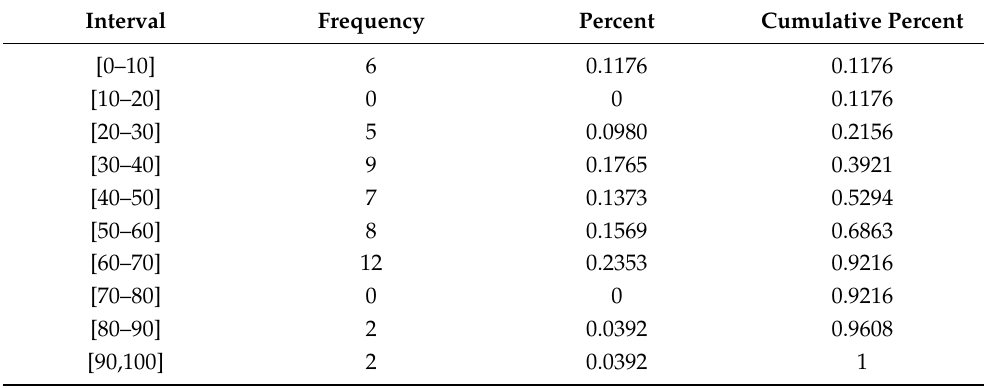
Table 6. Open access